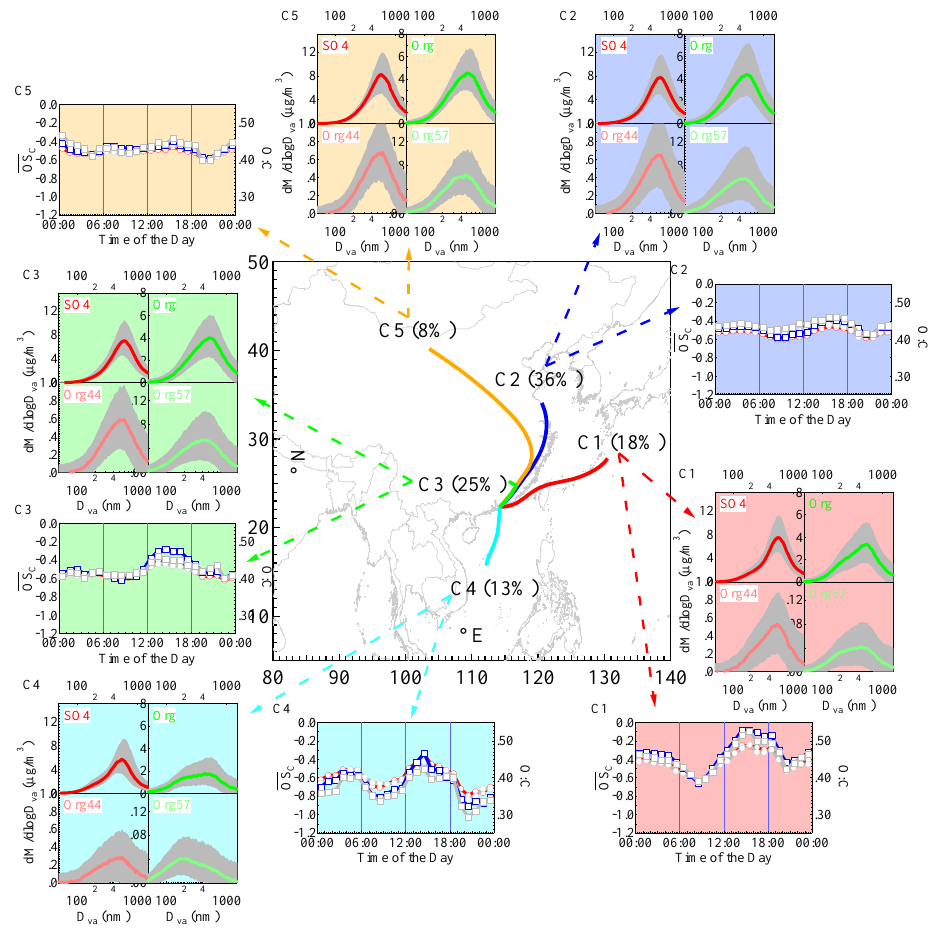
Figure 8. Average size distributions of sulfate (SO4), organics (Org), organics with m/z 44 (Org44) and organics with m/z 57 (Org57), and diurnal patterns of the degree of oxygenation of organics, as represented by average carbon oxidation state (OS C ) and O:C ratio in different clusters from the five-cluster solution at 300m arrival height. For size distributions, the colored lines indicate the average size distributions, while the grey areas indicate the IQRs. For diurnal patterns of OS C and O:C, legends are the same as those in Fig. 5 (on top of right panels).